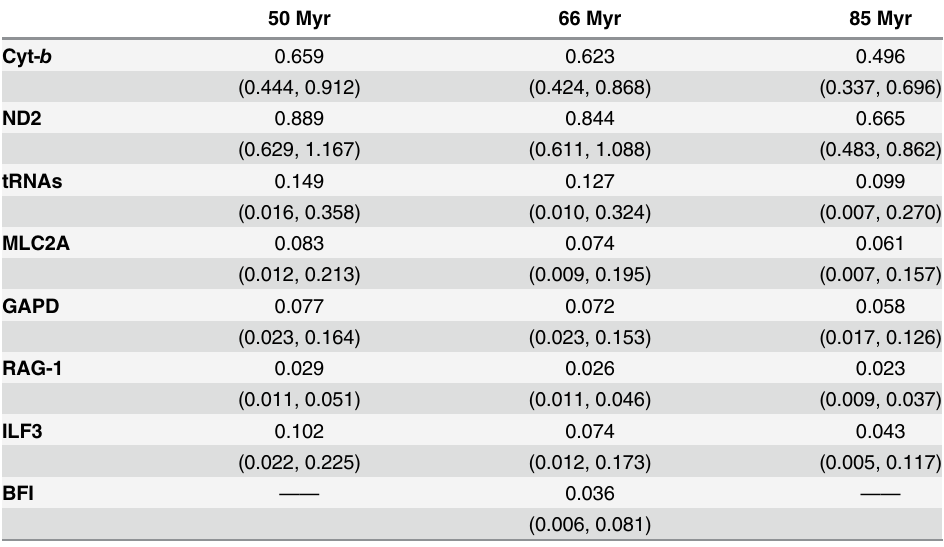
Table 3. Estimates of median rates of evolution. Three estimates of the age of the crown group of pletho- dontids were used [71]. 95% confidence intervals are in parentheses. For clarity, all values are multiplied by 100, and thus are the estimated percentage change per million